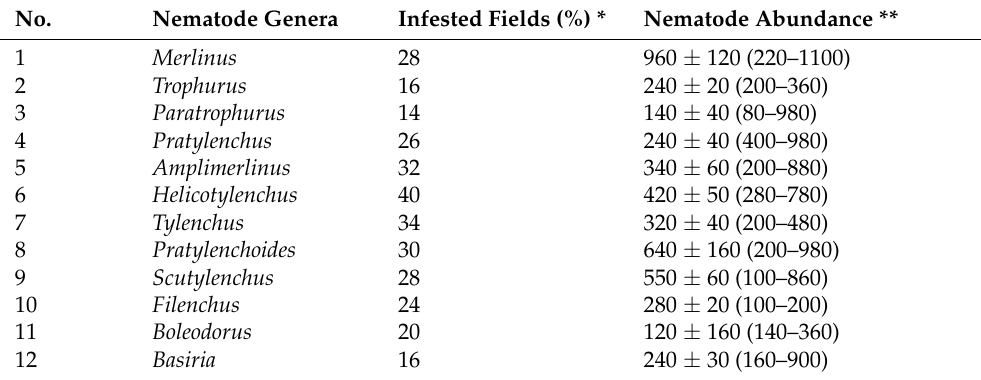
Table 3. Migratory nematode genera recovered from the sampled fields in Sakarya